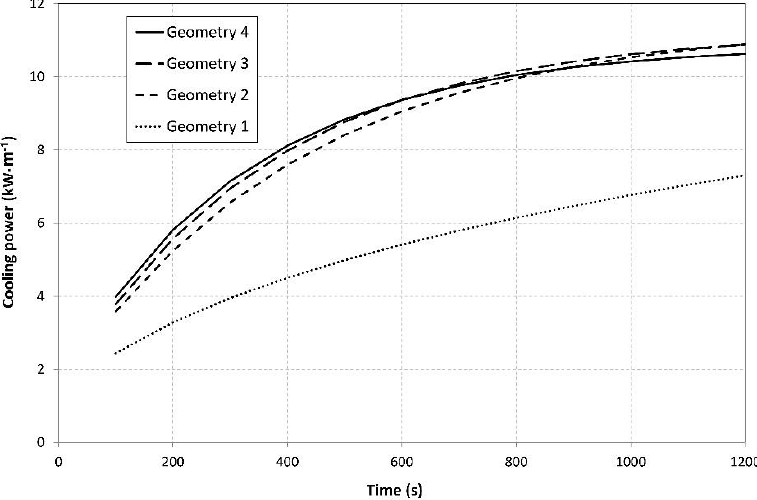
Figure 14. Heat fluxes, relative to the separator length, from the separator surface towards the surrounding environment with the employed cooling.